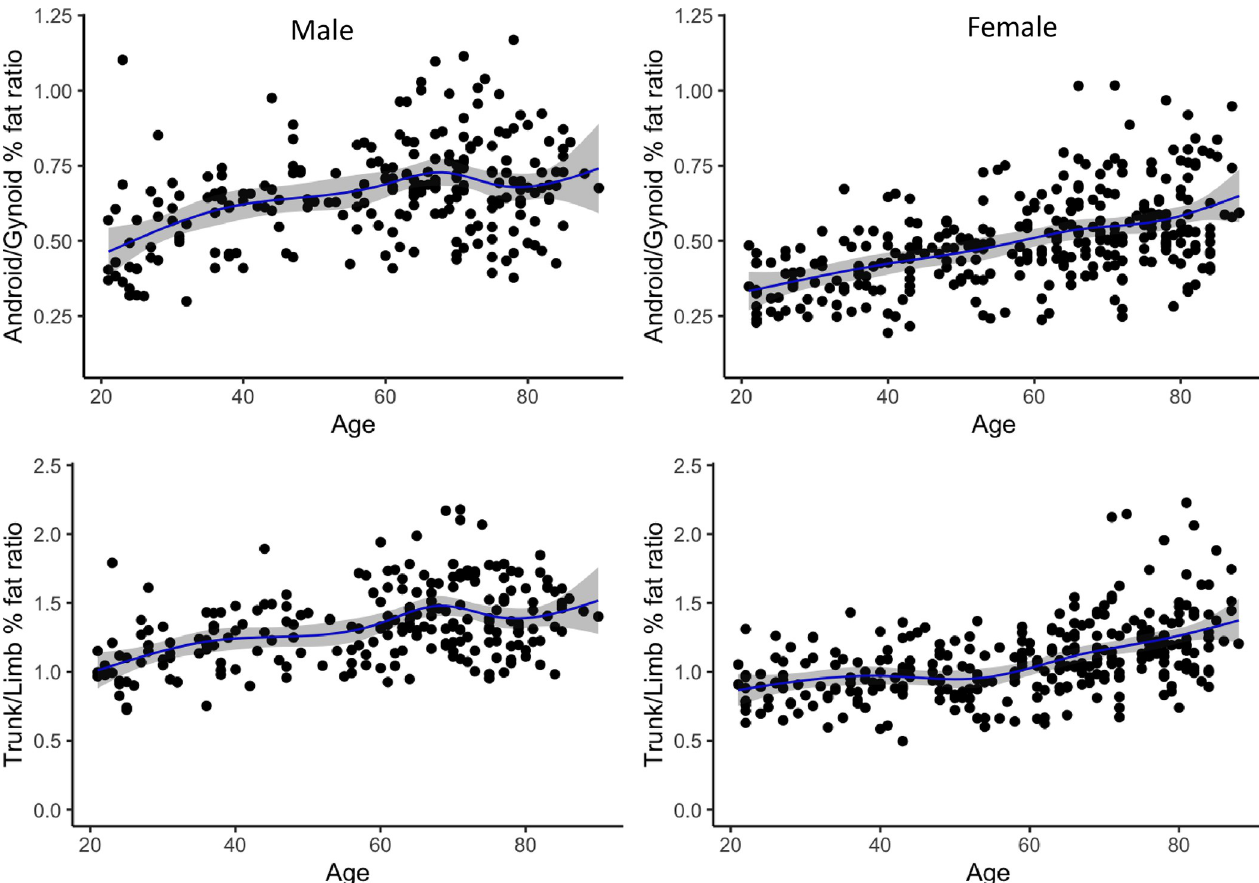
Fig 2. Natural spline regression by sex for Android/Gynoid % fat ratio and Trunk/Limb % fat ratio in men and women aged 21–90 years.